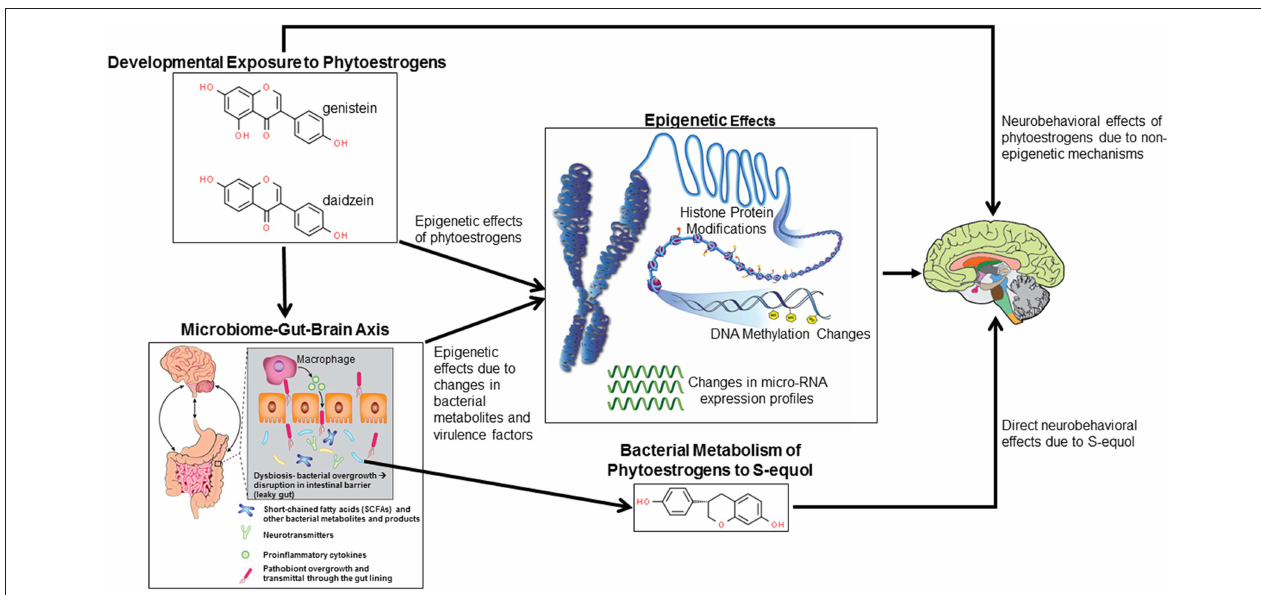
FIGURE 1 | Potential mechanisms by which developmental exposure to GEN and other phytoestrogens might alter neurobehavioral programming. Such compounds might induce epigenetic and non-epigenetic changes in the brain, leading to later behavioral alterations. Phytoestrogens might alter gut microbial species leading to disruptions of the microbiome-gut-brain axis. Bacterial metabolites and virulence factors may induce host epigenetic modifications that alter neurobehavioral responses. Select bacteria may metabolize phytoestrogens to more potent metabolites, in particular S-equol, that can cause neurobehavioral